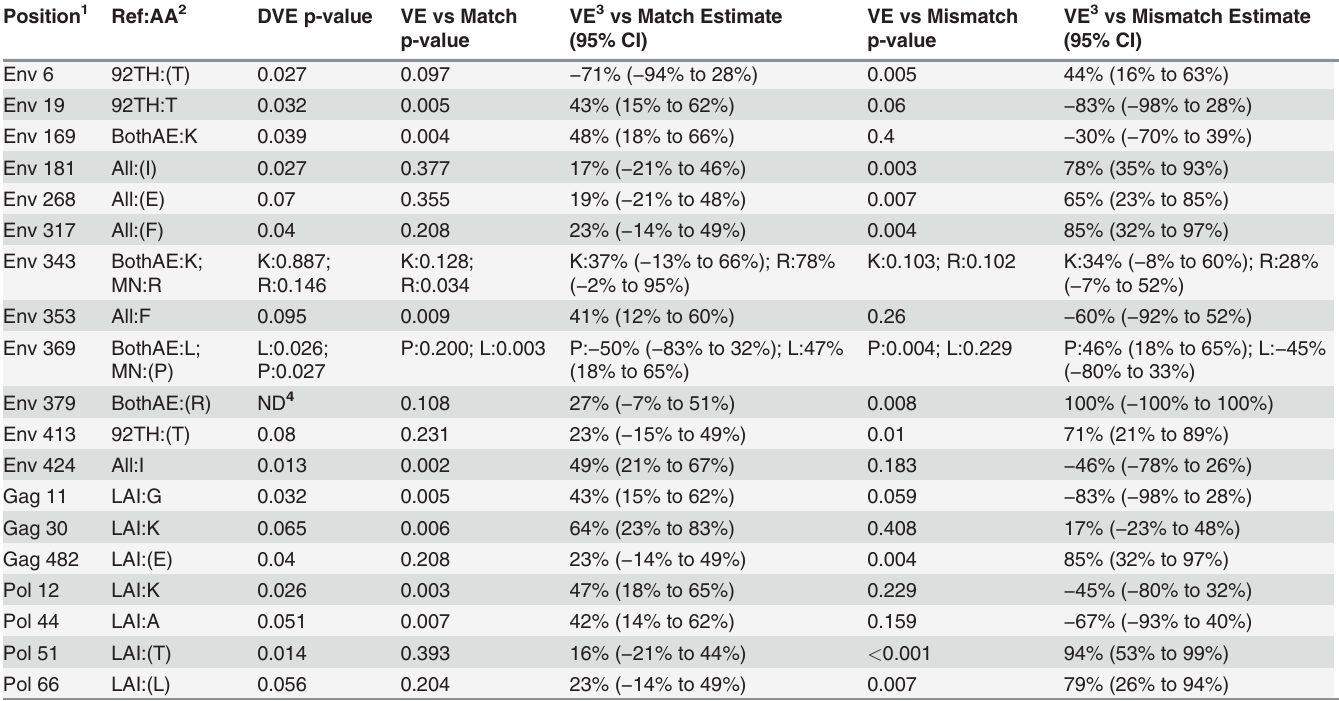
Table 3. Vaccine ef fi cacy at the signature sites in the vaccine